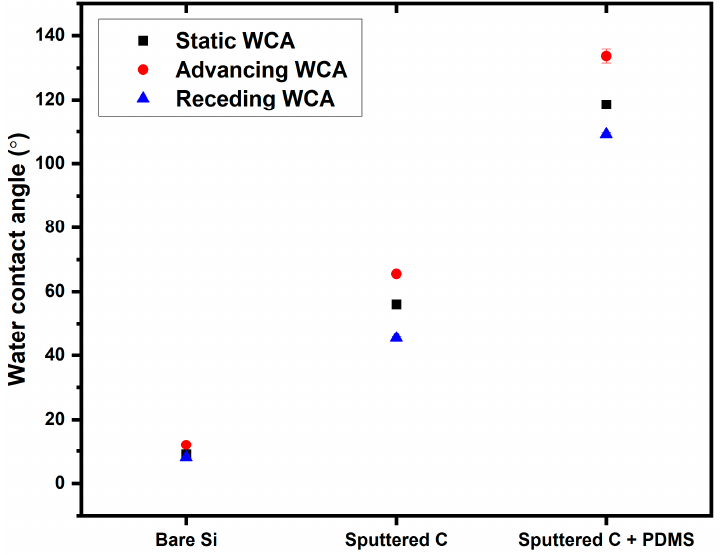
Figure 3. Static, advancing, and receding WCAs of a bare silicon surface, a silicon surface coated with sputtered carbon, and the carbon surface coated with PDMS. The error bars for these results are smaller than the symbols used here.